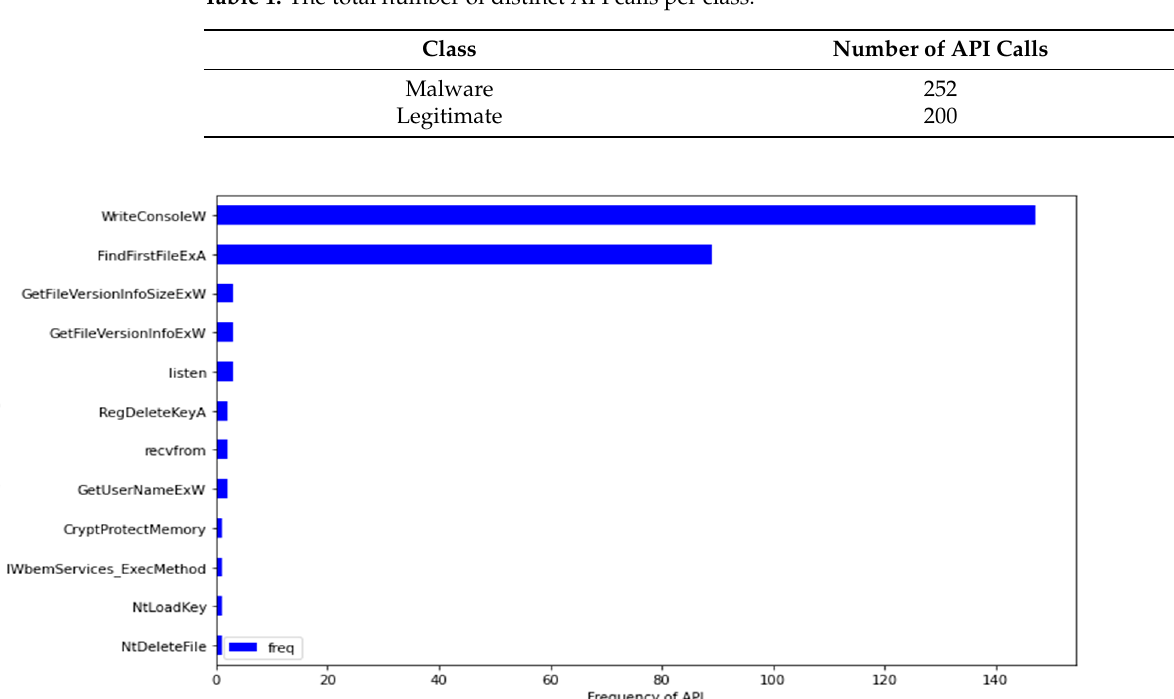
Table 1. The total number of distinct API calls per class.